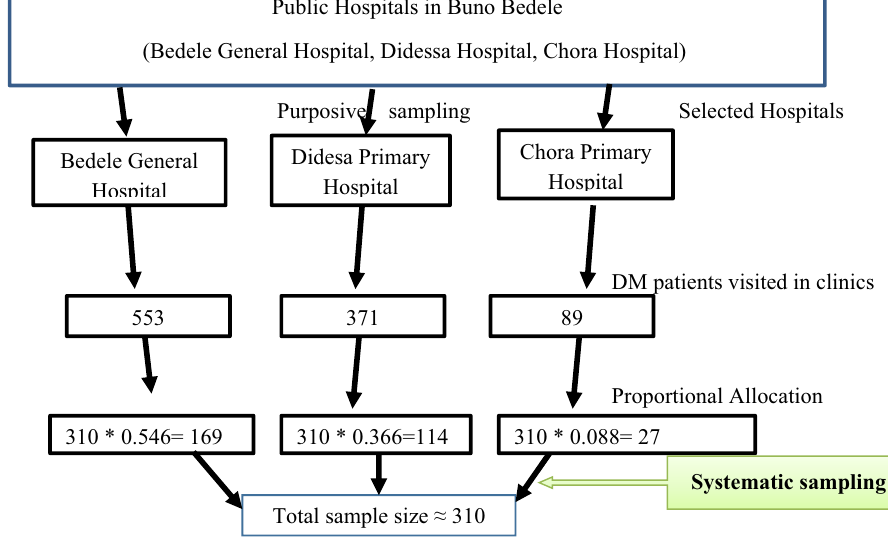
Figure 1. Schematic diagram showing sampling procedure for depression among diabetic patients attending follow-up at hospitals in Buno Bedele, Southwest Ethiopia,